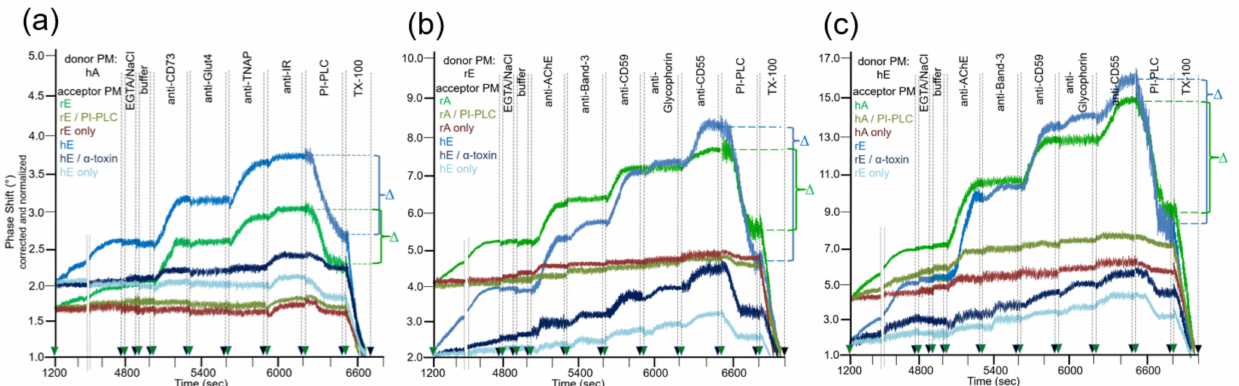
Figure 3. Set-up of chip-based sensing system for transfer of GPI-APs and transmembrane proteins from donor to acceptor PM at various combinations. Human adipocyte ( a ), rat erythrocyte ( b ), and human erythrocyte ( c ) donor PM or washing buffer (acceptor PM only) were injected (at 800–1200 s) into chips with rat erythrocyte ( a , c ), human erythrocyte ( a , b ), rat adipocyte ( b ), or human adipocyte ( c ) acceptor PM consecutively captured via ionic (Ca 2+ ) and covalent bonds as described for Figure 2. The chips were then incubated (1 h, 37 ◦ C) at flow rate 0 (double hatched lines) until 4800 s in the absence or presence of PI-PLC or α -toxin, as indicated. Following injection of EGTA/NaCl and then washing buffer, the protein composition of the acceptor PM was assayed by sequential injection of antibodies against GPI-APs and transmembrane proteins, then of PI-PLC, and finally of TX-100 (0.1%) as indicated. The measured phase shift is given upon correction for unspecific interaction (chips lacking acceptor PM) and normalization for variable capturing efficacy. The differences ( ∆ ) between total phase shift upon injection of the last antibody and the phase shift left at the end of injection of PI-PLC are indicated by horizontal hatched lines and brackets as a measure for GPI-AP transfer for each donor–acceptor PM combination. The experiment was repeated two times with similar